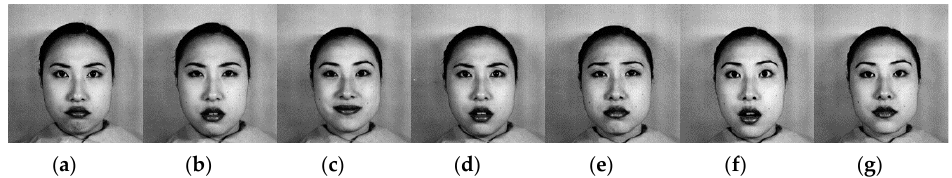
Figure 1. Images taken from the Japanese female facial expression (JAFFE) dataset showing various emotions: ( a ) anger, ( b ) disgust, ( c ) happy, ( d ) fear, ( e ) sad, ( f ) surprise and ( g ) neutral.